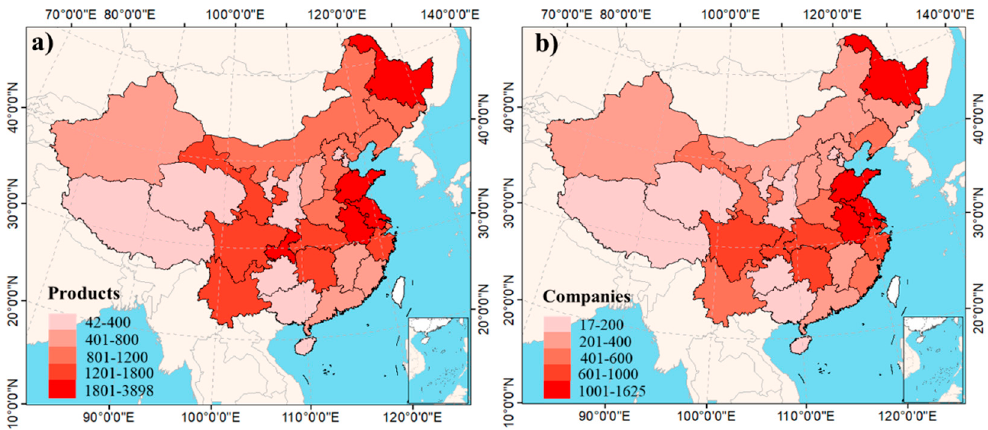
Figure 5. Green food categories and their corresponding proportions on the basis of the amount of product in China.